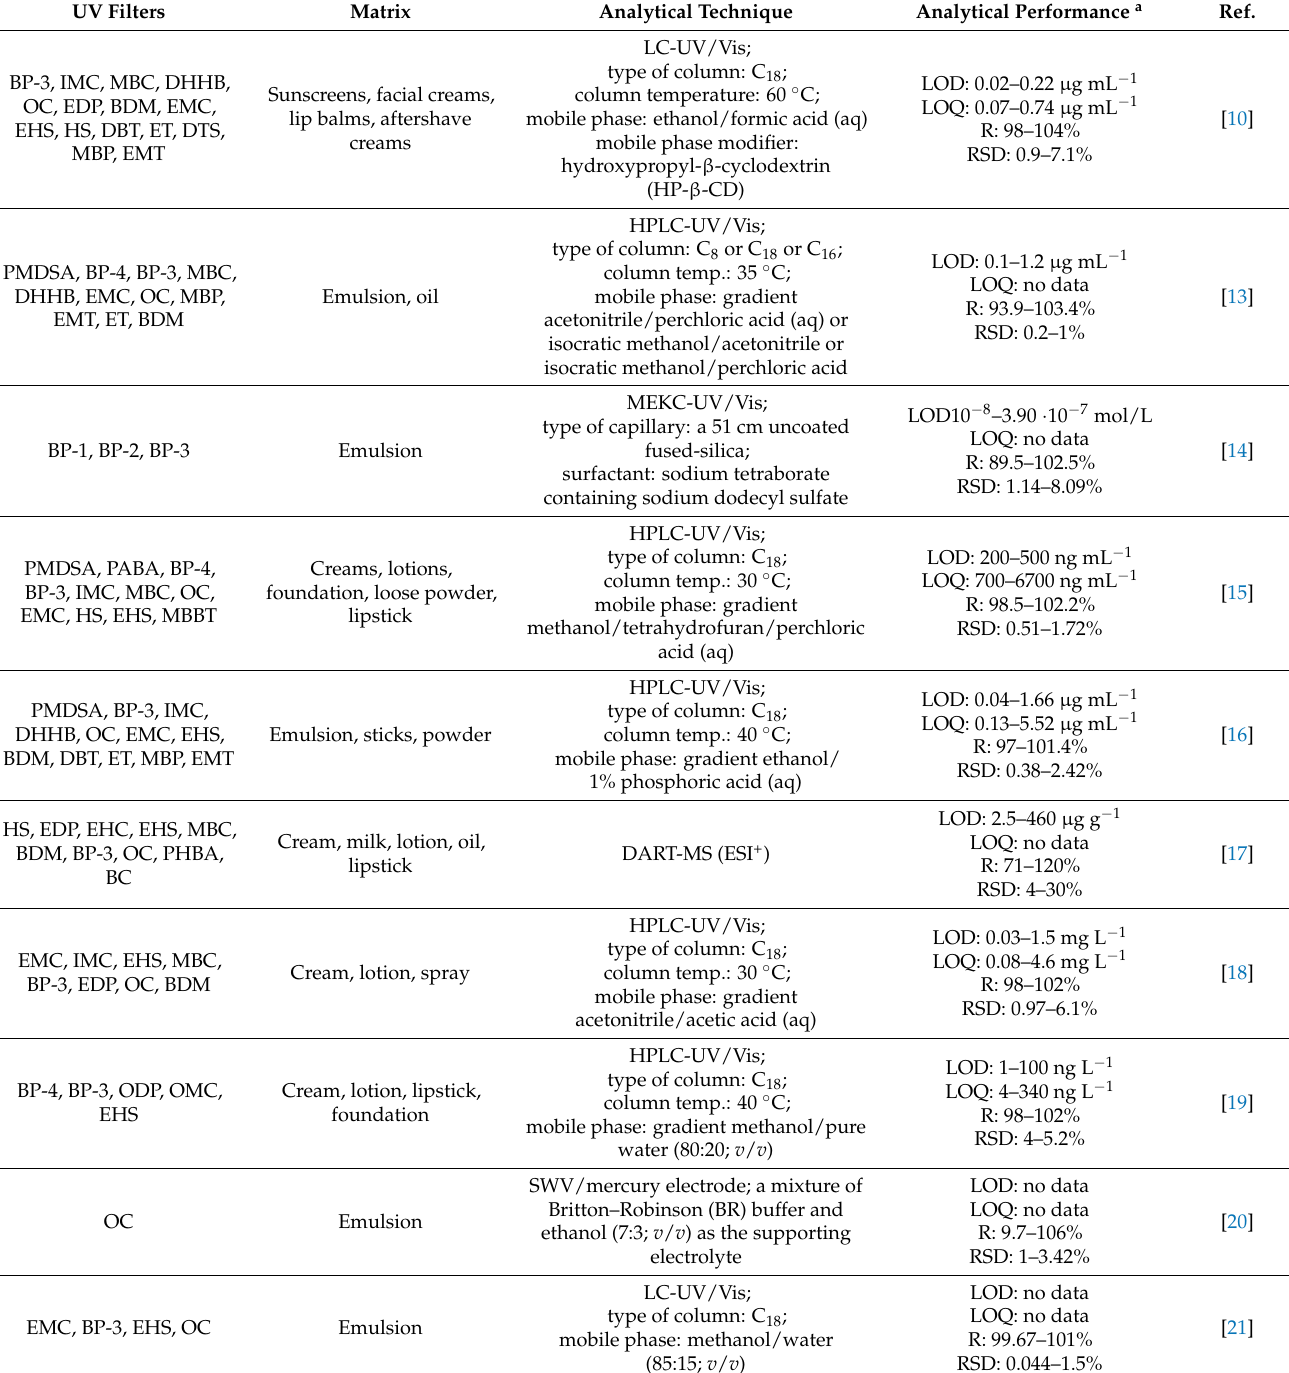
Table 2. Published studies on UV filters determination in cosmetic